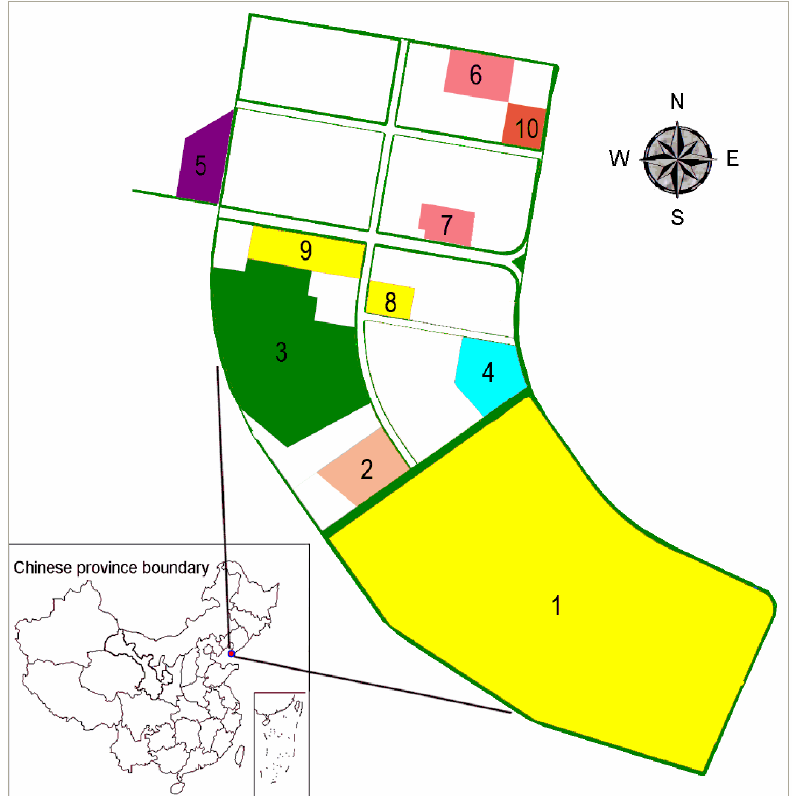
Figure 2. Location of the Songmu Island Chemical Industrial Park,